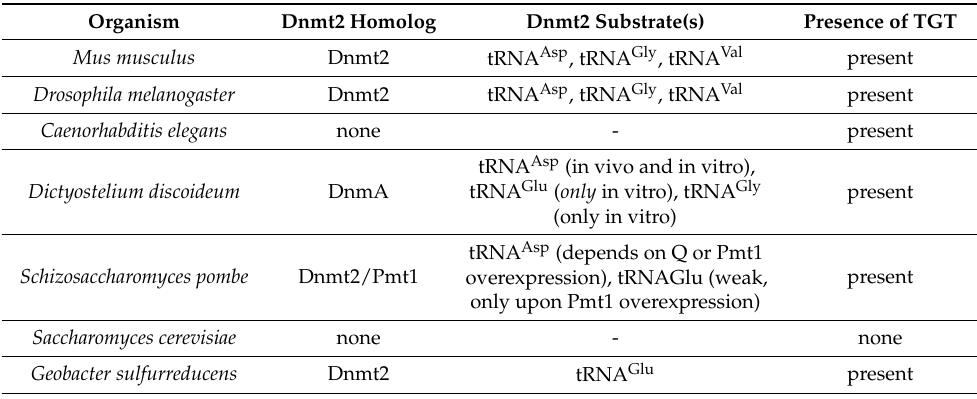
Table 1. Overview over Dnmt2 homologs and their substrates and the presence of the transfer RNA (tRNA) guanine transglycosylase (TGT) in several model organisms. Organism Dnmt2 Homolog Dnmt2 Substrate(s) Presence of TGT Mus musculus Dnmt2 tRNA Asp , tRNA Gly , tRNA Val present Drosophila melanogaster Dnmt2 tRNA Asp , tRNA Gly , tRNA Val present Caenorhabditis elegans none - present tRNA Asp (in vivo and in vitro), Dictyostelium discoideum DnmA present tRNA Glu ( only in vitro), tRNA Gly (only in vitro) tRNA Asp (depends on Q or Pmt1 Schizosaccharomyces pombe Dnmt2/Pmt1 overexpression), tRNAGlu (weak, only upon Pmt1 overexpression)